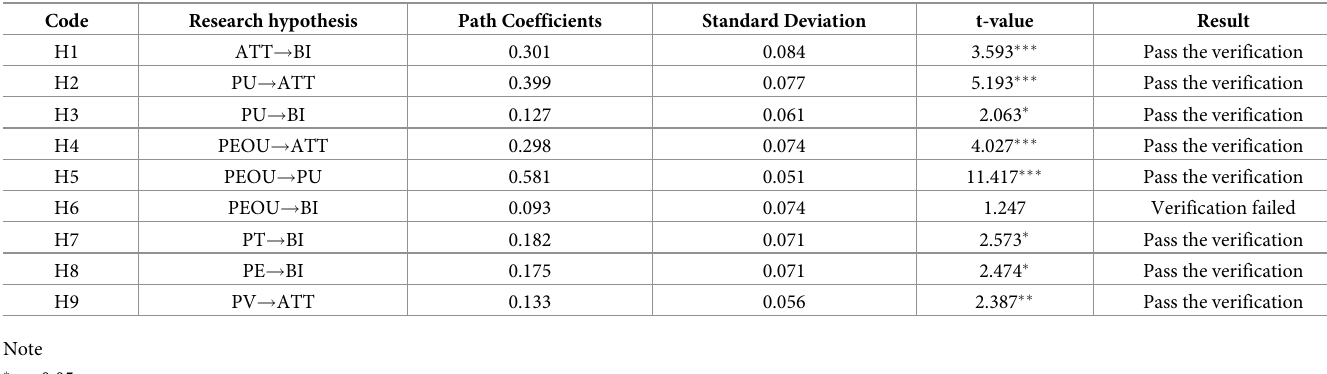
Table 4. Research hypothesis evaluation